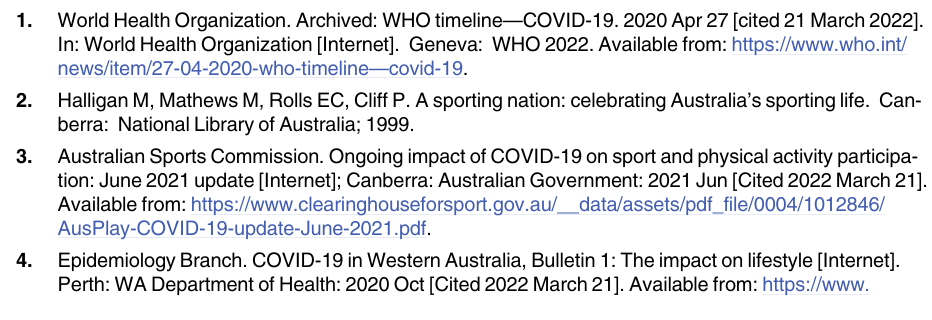
S1 Table. Coding framework: Pre-lockdown, during lockdown, and